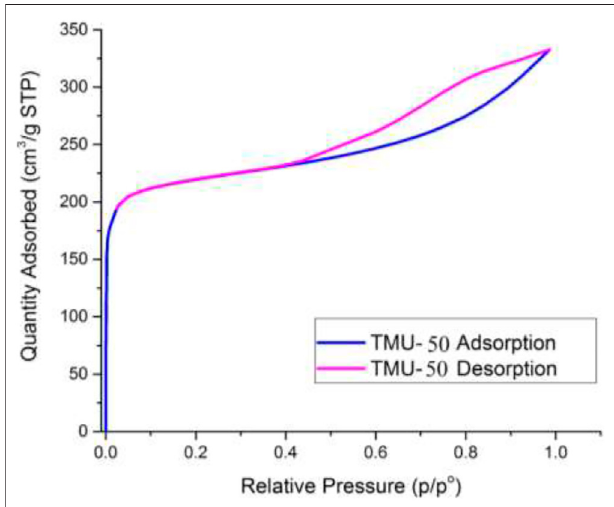
FIGURE 6 | Nitrogen adsorption-desorption isotherms at 77 K. for Nano-TMU-50.